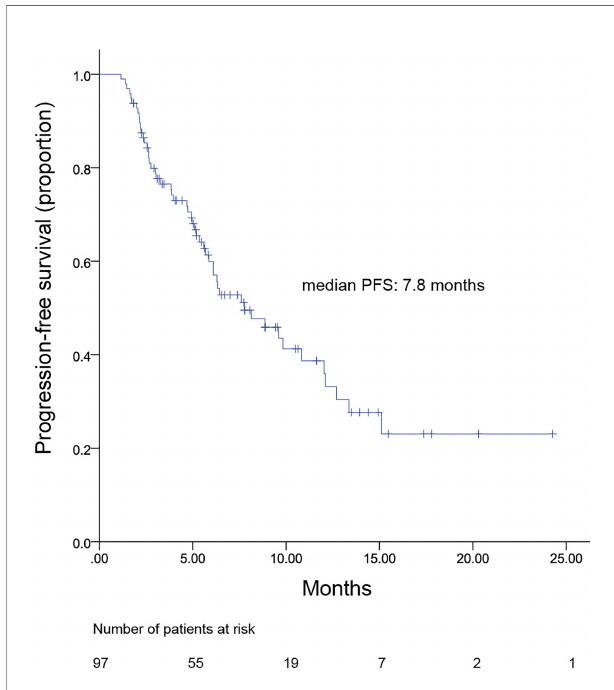
FIGURE 1 | Kaplan – Meier curve for progression-free survival of all patients.